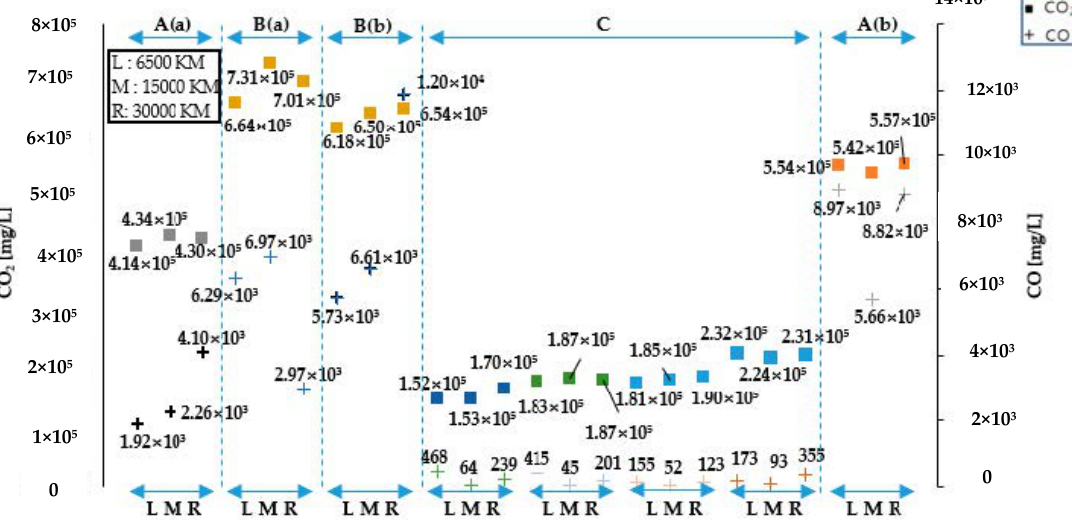
Figure 10. Total amount of CO 2 and CO emitted during acceleration and deceleration regions in the city mode of the US06 driving cycle.